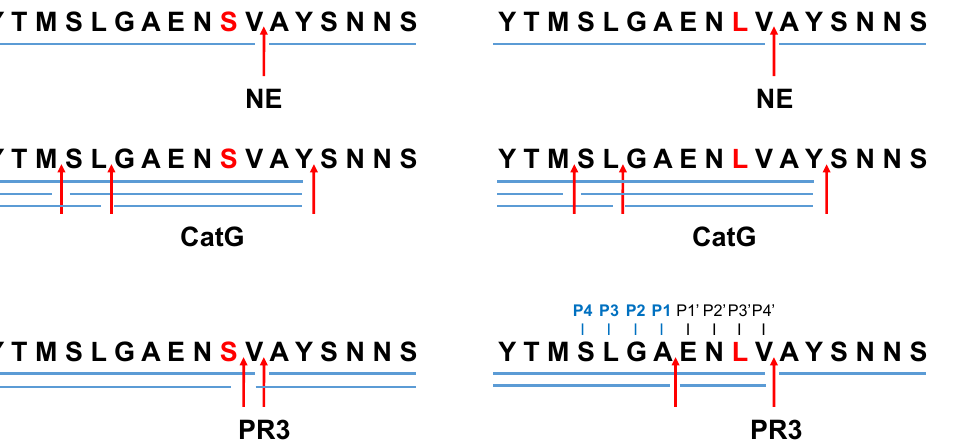
Figure 1. Cleavage site prediction for NE. Potential cleavage sites of 695 YTMSLGAEN S VAYSNNS 711 (S704 peptide) and 695 YTMSLGAEN L VAYSNNS 711 (L704 peptide) were mapped for NE by using “ExPASy peptide cutter” and indicated by red arrows.